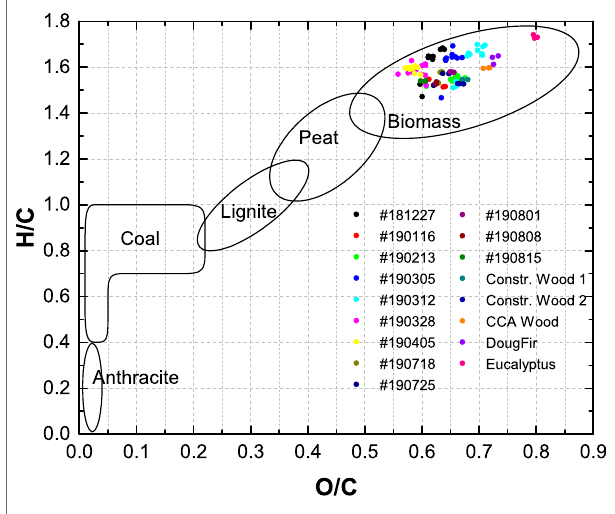
FIGURE 3 | Van Krevelen diagram for CCDWDF materials and reference